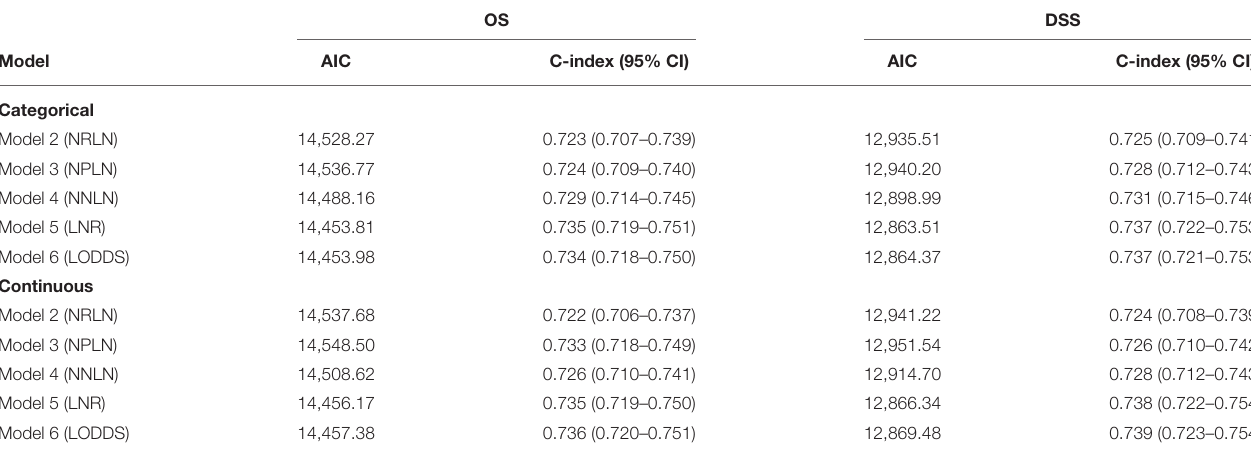
TABLE 3 | Predictive performance of different LN schemes.